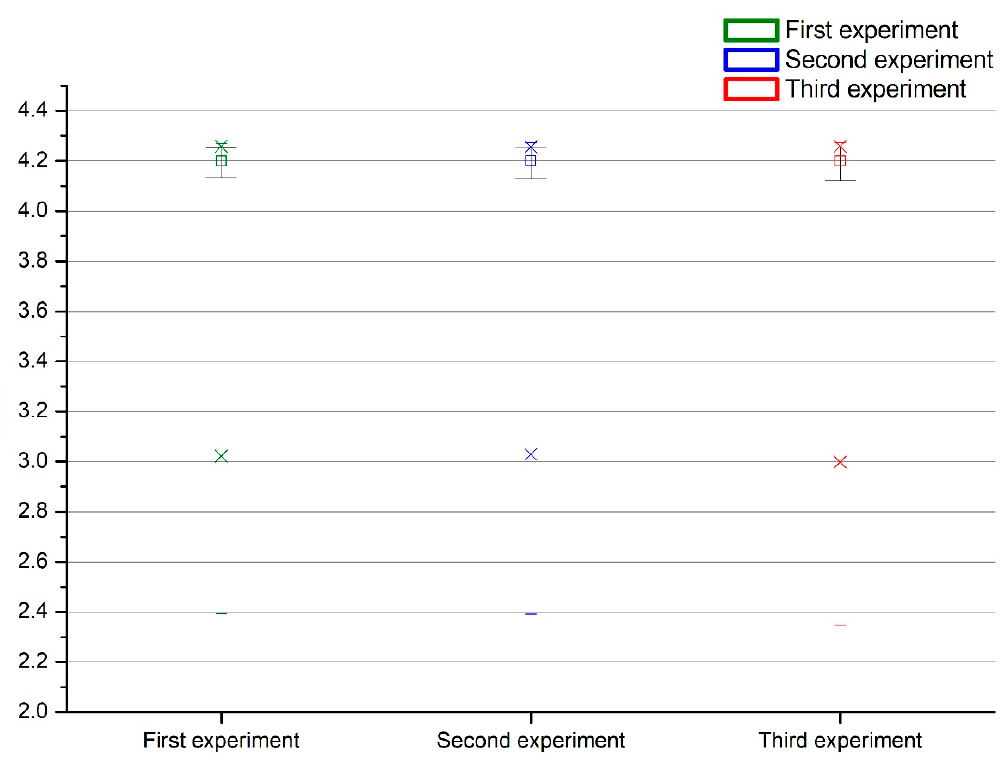
Figure 28. The confidence interval of MOS of the three experimental results for the LTE event A3 handover mechanism.